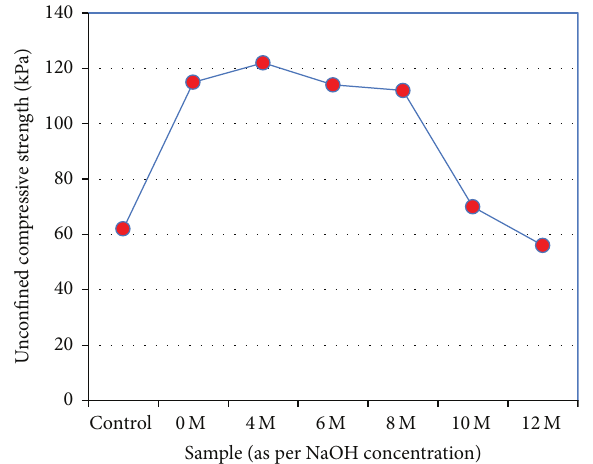
Figure 3: Effect of NaOH concentration on the resulting solidified 7-day strength of soil-slag (5: 5)